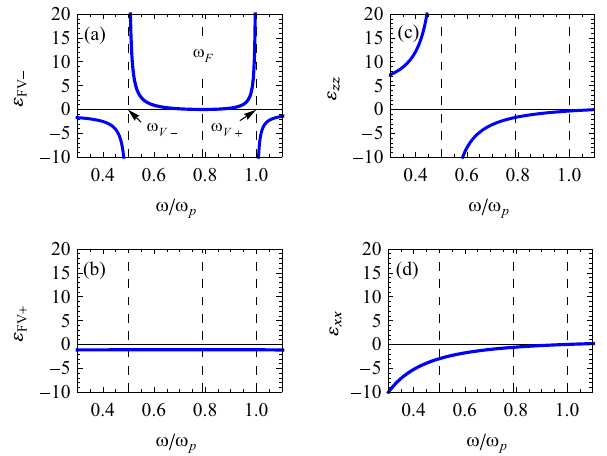
Figure 2. Variation of ( a ) ε FV ω/ω p , when ε 1